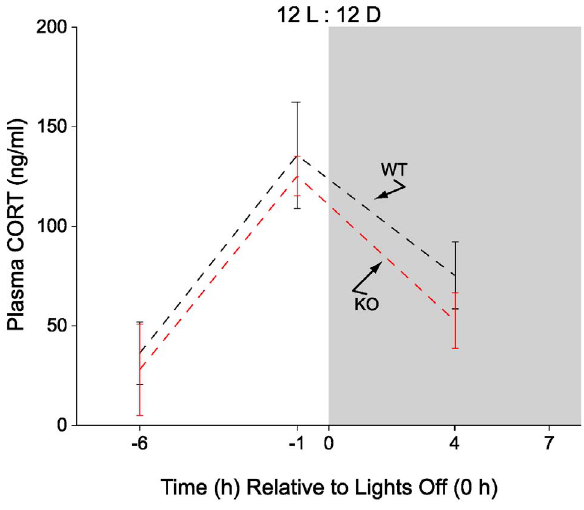
Figure 3. Compilation of plasma CORT data from Experiments 1 & 2 normalized relative to activity onsets. Peak CORT values at 1 h before activity onset of wild type (WT) mice maintained under 12L:12D and 9.5L:13.5D and 5-HT 1B knockout (KO) mice maintained under 12L:12D conditions were similar and significantly greater than 2 1 h CORT values of KO mice maintained under 9.5L:13.5 D conditions (p , 0.01).